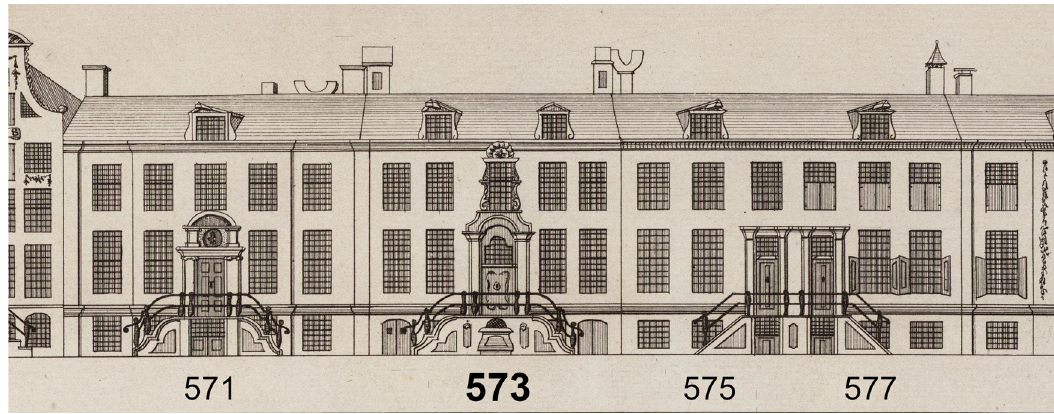
Figure 1: The Herengracht 573 and neighboring houses in Caspar Philips ’ Grachtenboek ( 1768 – 1771 ) , the earliest preserved visual reference of its façade.